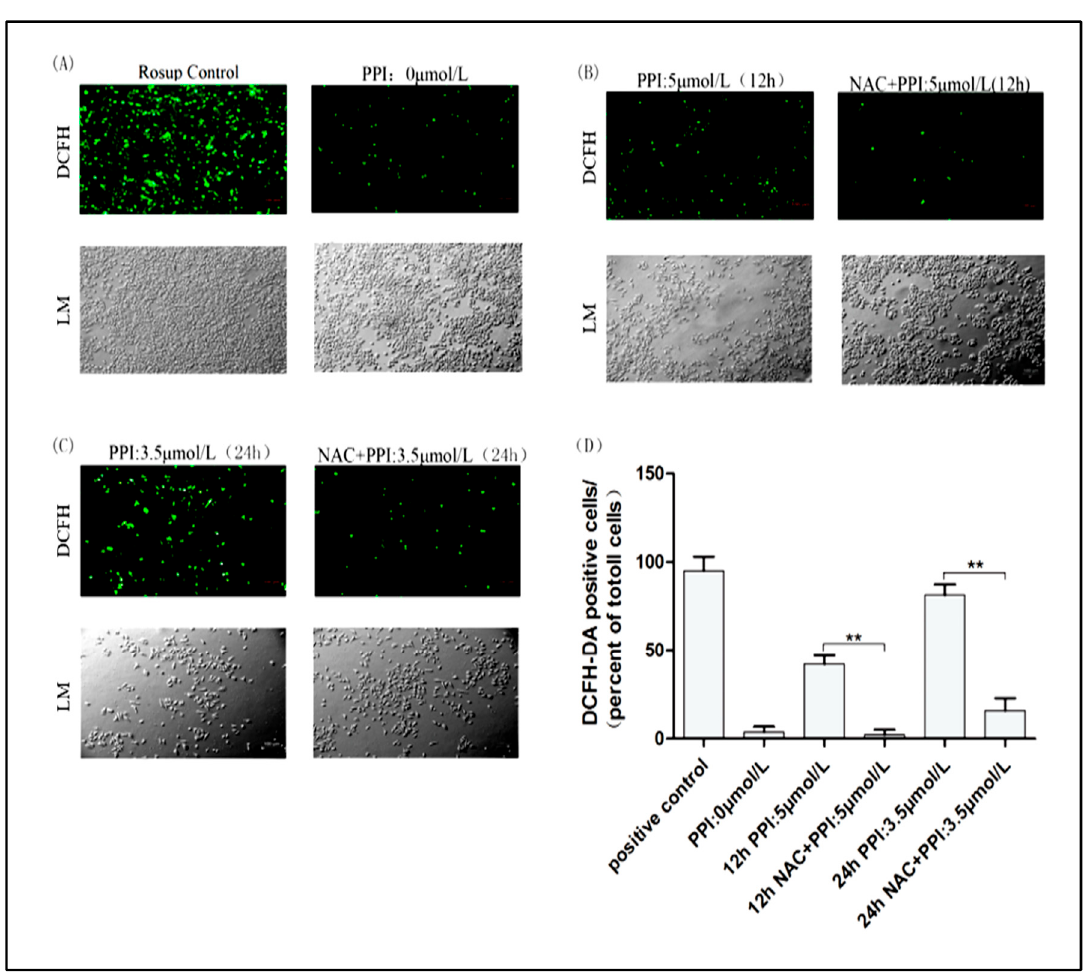
Figure 7. Changes in ROS levels in SW480 cells were assayed by DCFH labeling (1000×). ( A ) Rep ‐ resentative images of ROS production in Rosup ‐ positive and ‐ negative control groups (PPI: 0 μ mol/L); ( B , C ) representative images of ROS production in PPI ‐ and NAC + PPI ‐ treated groups; ( D ) quantification of the DCFH ‐ positive cells. n = 3, the data are presented as means ± SEM. ** p < 0.01.